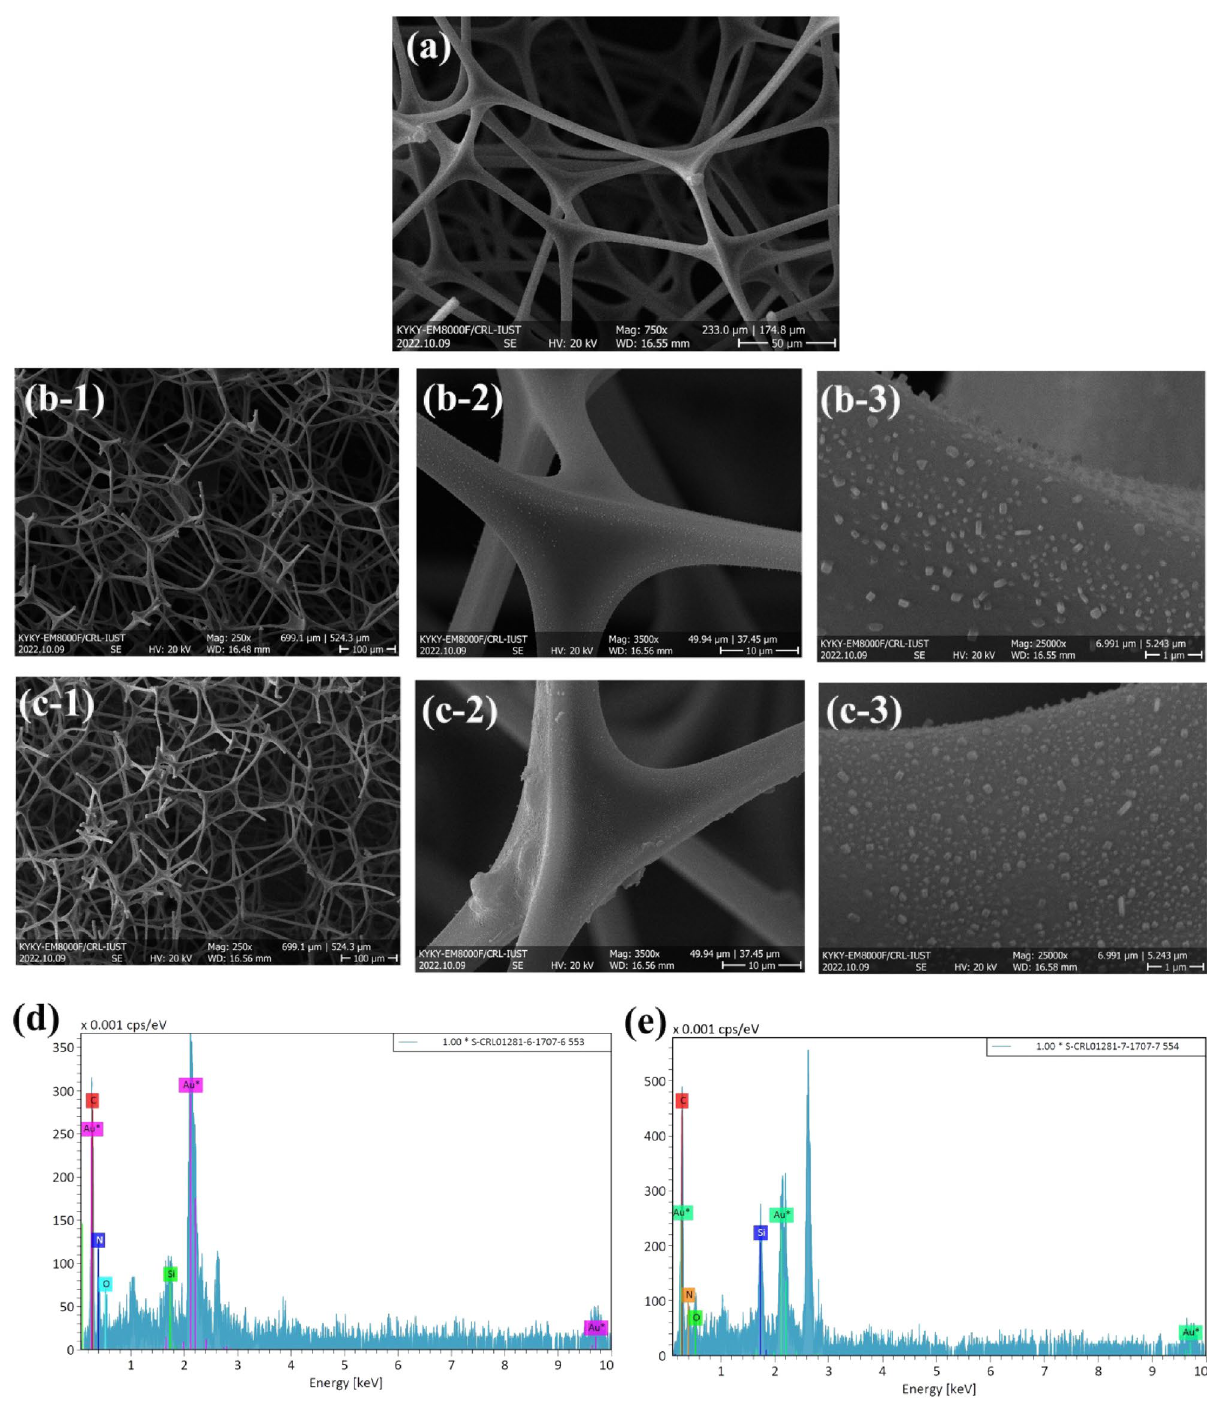
Figure 5. FESEM images of ( a ) pristine MF, ( b ) PC/MF, and ( c ) MWCNT/MF, and EDX spectrum of ( d ) MWCNT/MF and ( e )